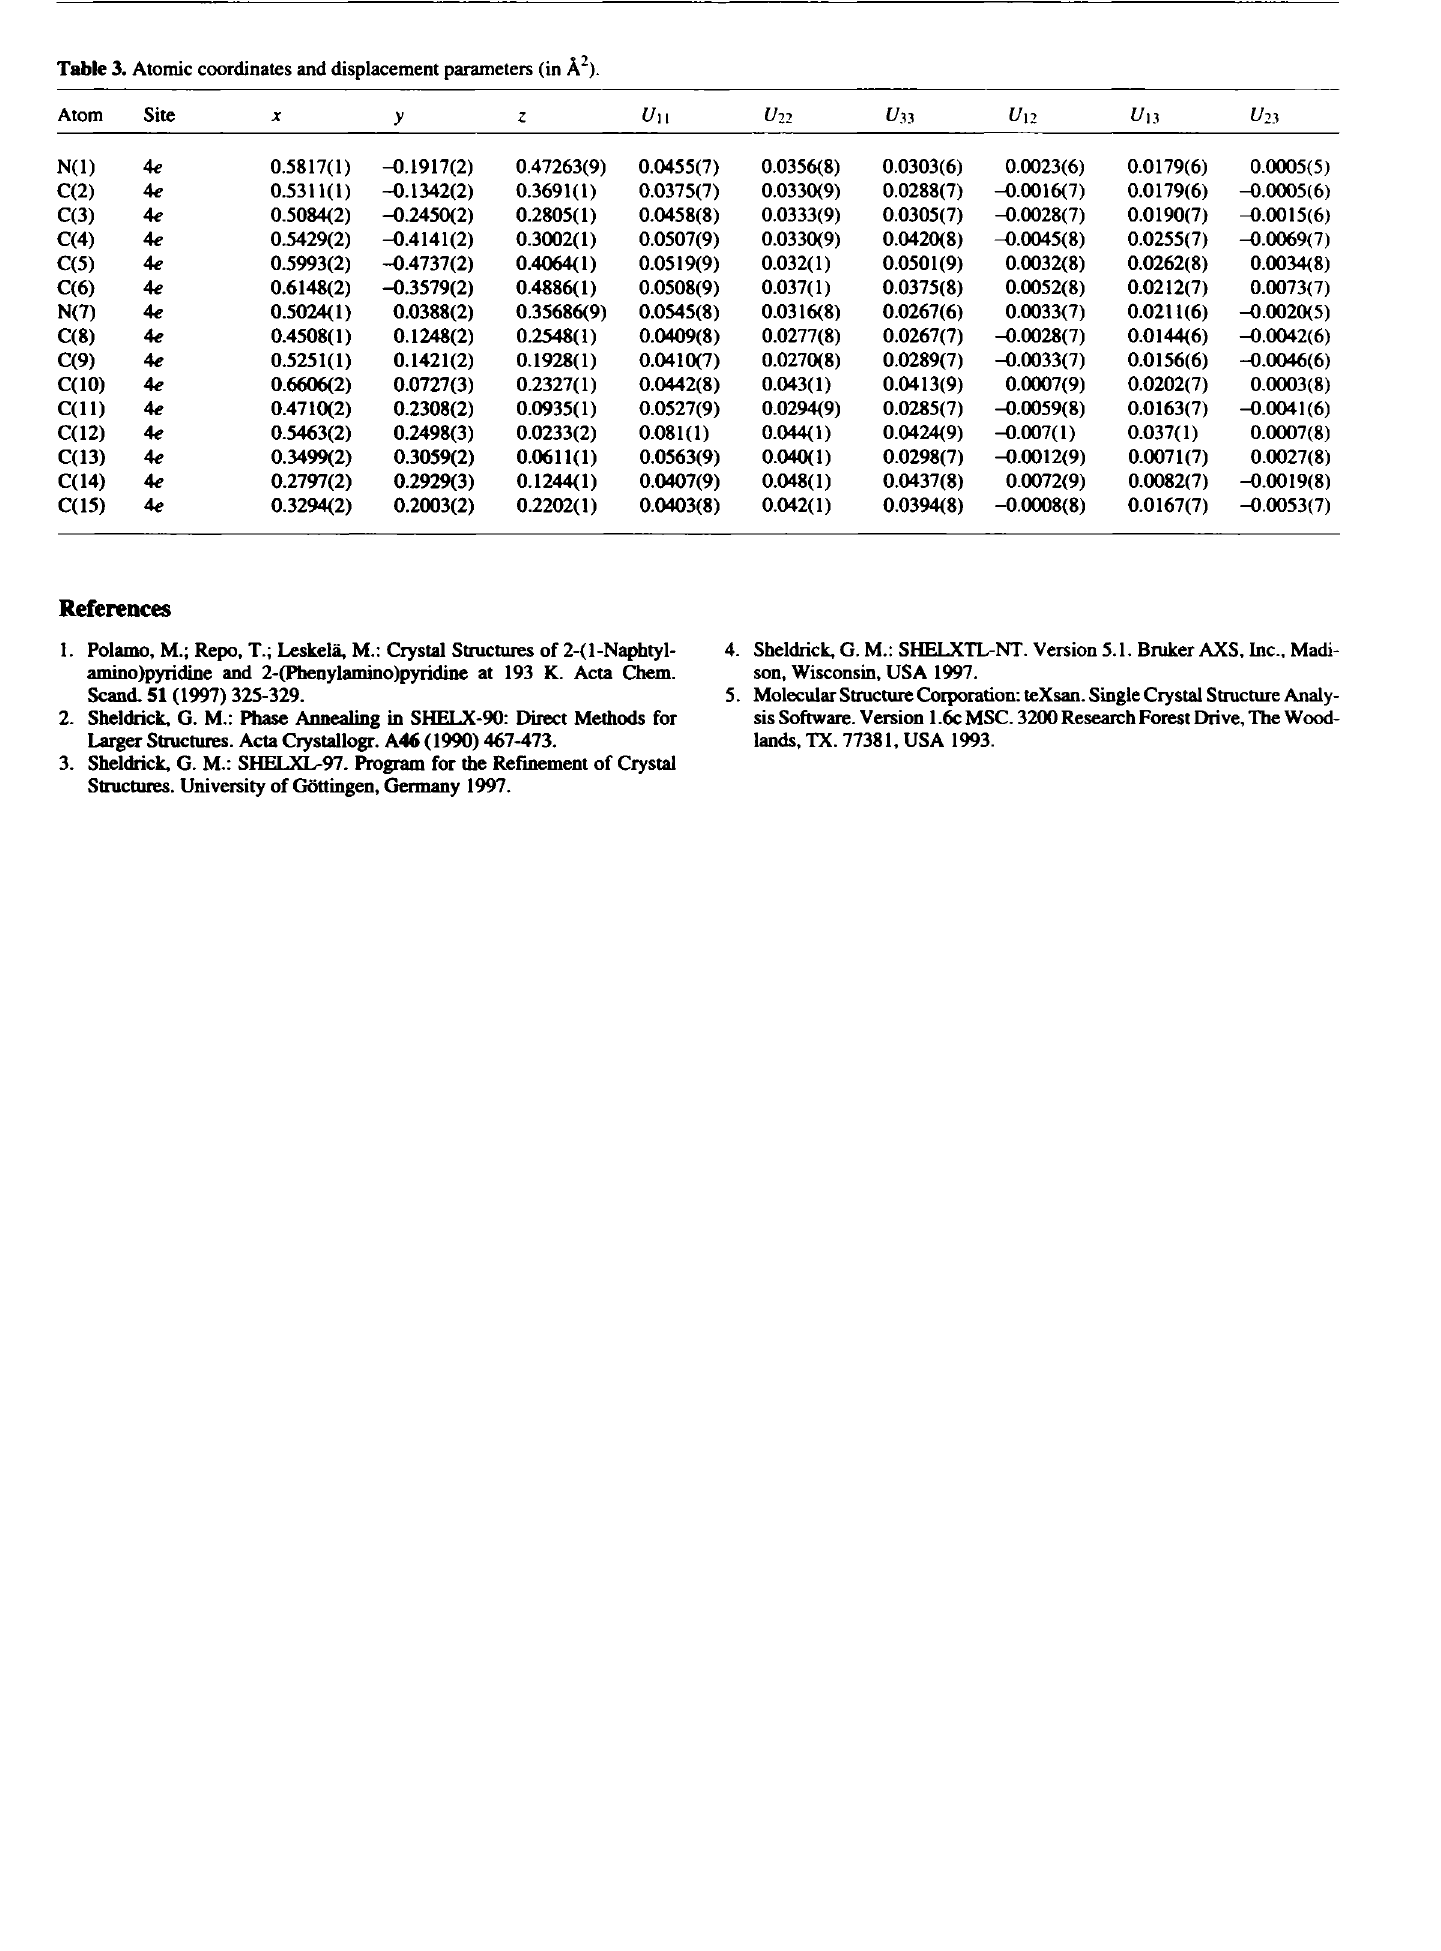
Table 3. Atomic coordinates and displacement parameters (in À 2